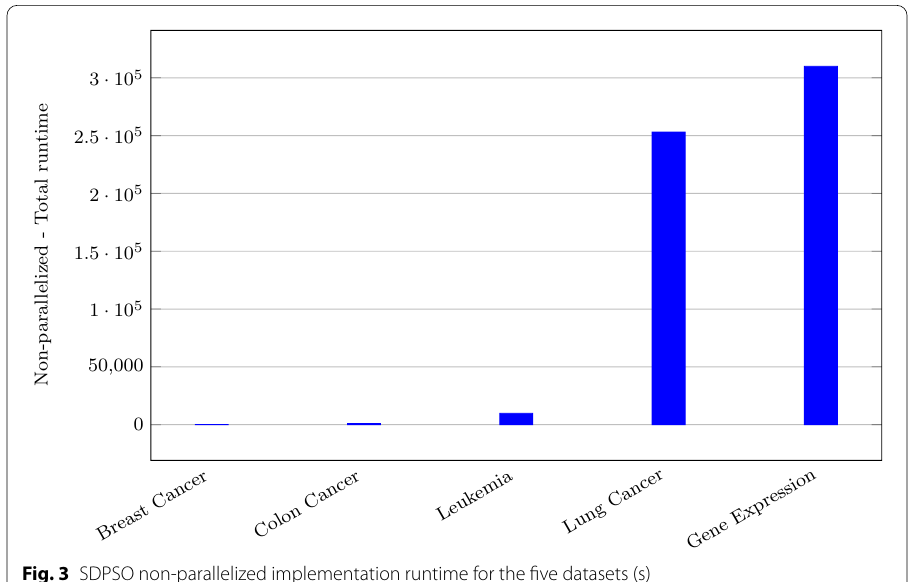
Fig. 3 SDPSO non-parallelized implementation runtime for the five datasets (s)